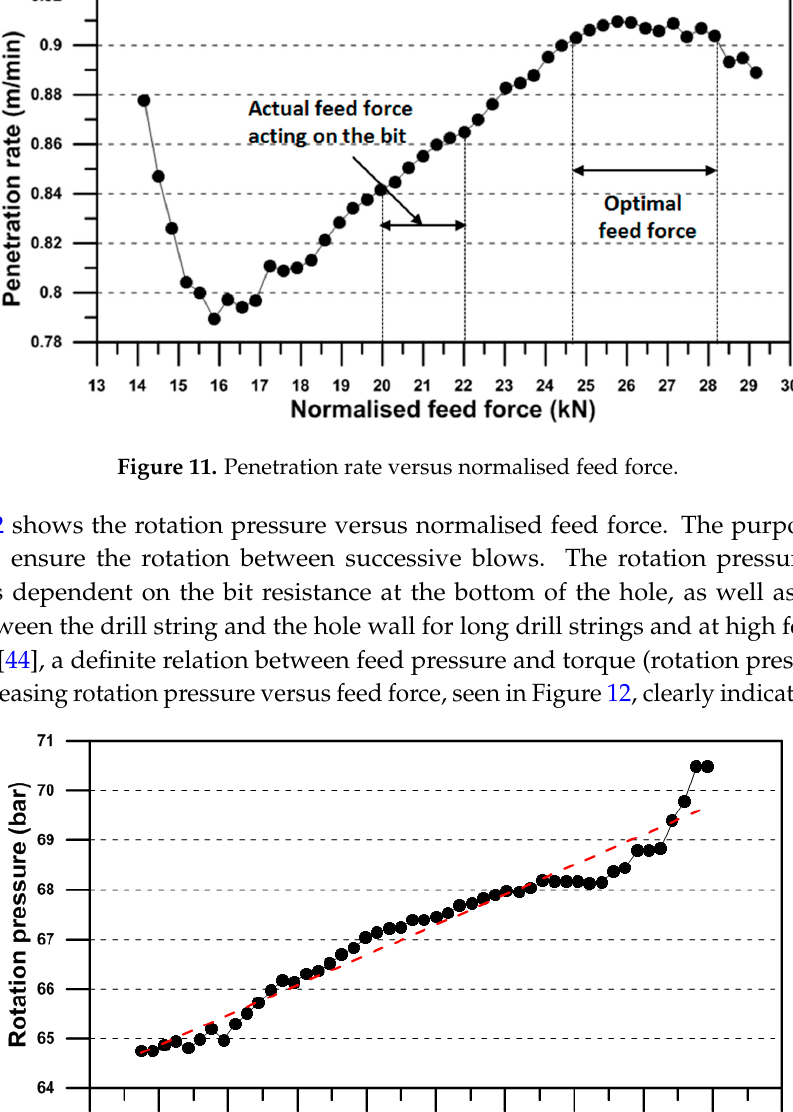
Figure 12. Rotation pressure versus normalised feed force.